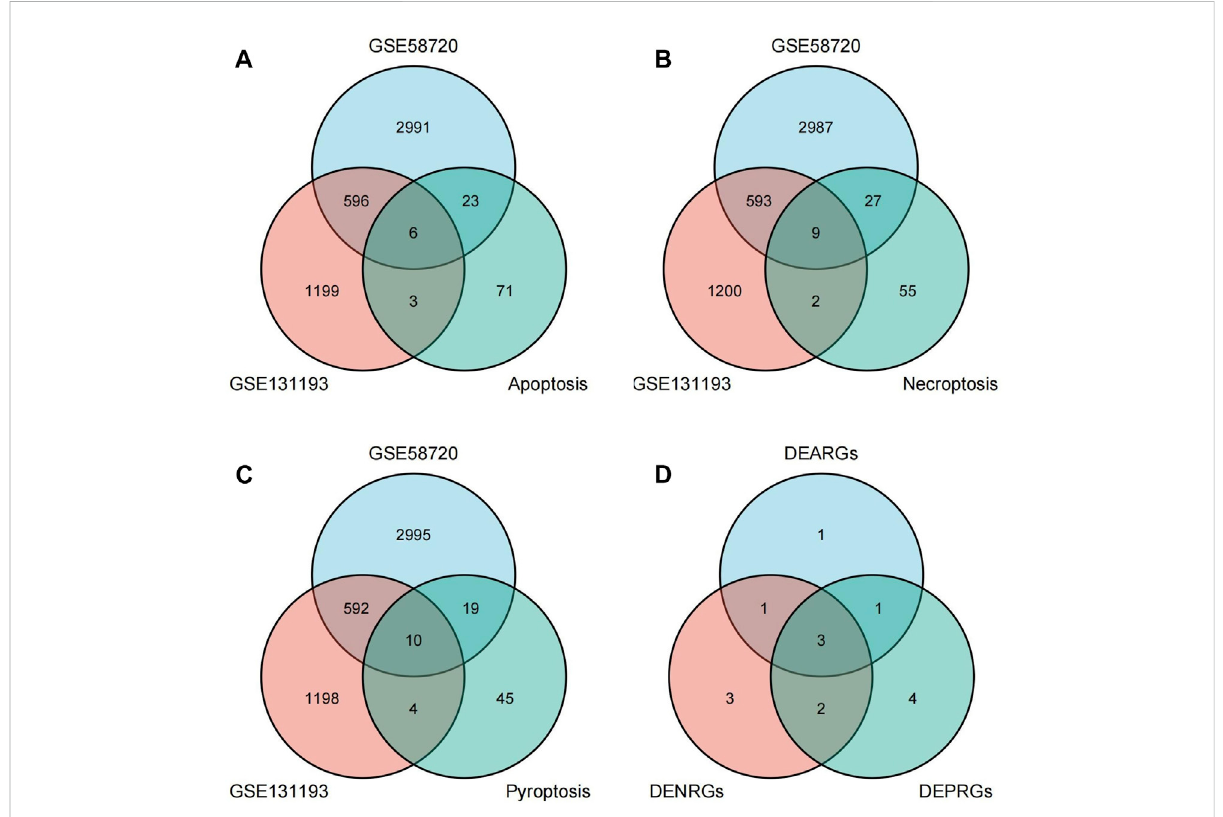
FIGURE 2 Identi fi cation of differentially expressed programmed cell death (PCD)-related genes. (A) Differentially expressed apoptosis-related genes (DEARGs)wereidenti fi edbydeterminingtheoverlapofdatasetsGSE58720andGSE131193withapoptosis-relatedgenes. (B) Differentiallyexpressed necroptosis-related genes (DENRGs) were identi fi ed by determining the overlap of datasets GSE58720 and GSE131193 with necroptosis-related genes. (C) Differentially expressed pyroptosis-related genes (DEPRGs) were identi fi ed by determining the overlap of datasets GSE58720 and GSE131193 with pyroptosis-related genes. (D) The overlapping genes were identi fi ed among DEARGs, DENRGs, and